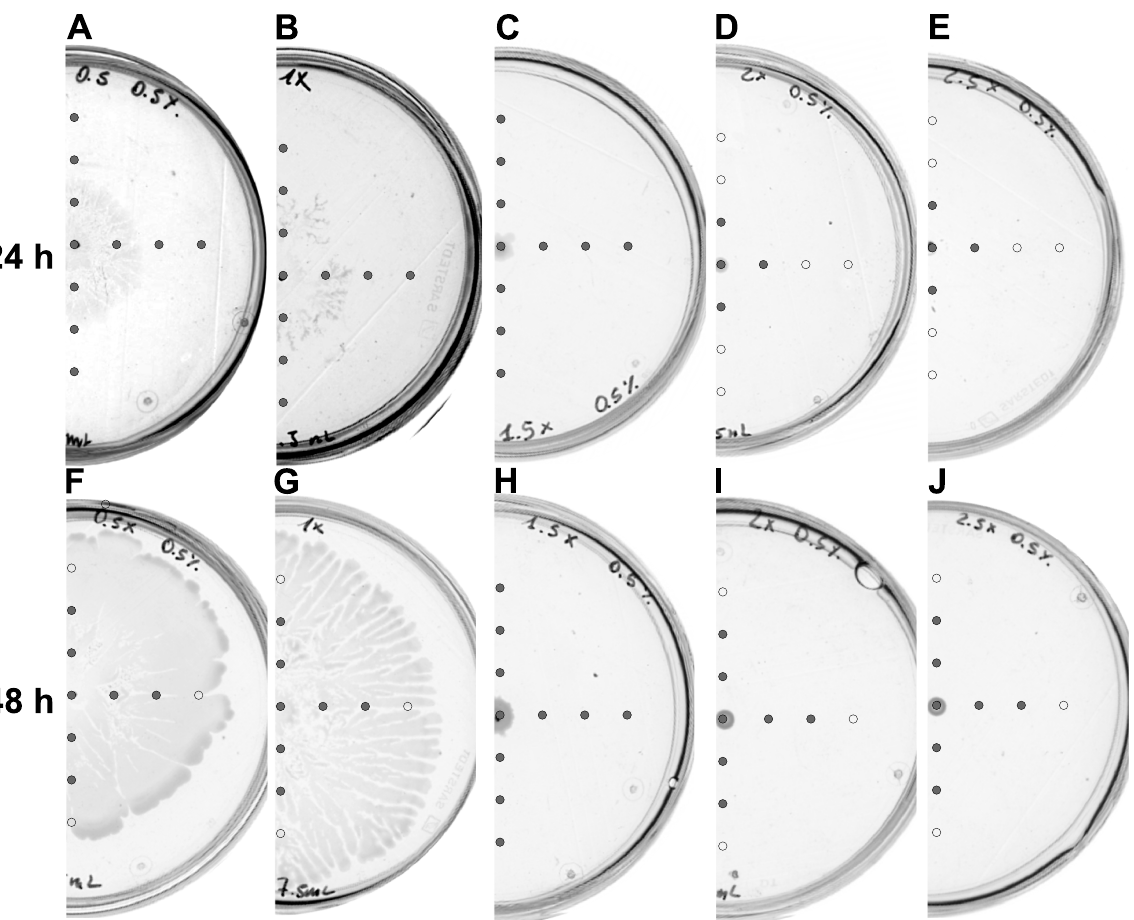
Fig 3. Swarming and AHLs production by Dickeya solani IFB102 on plates containing 0.5% of glucose, 0.5% of agar and the following concentrations of remaining components of B-medium: (A, F) 0.5x, (B, G) 1x, (C, H) 1.5x, (D, I) 2x, (E, J) 2.5x. Swarming assays were performed for 24 and 48 h, as indicated. Grey circles represent spots at which AHLs were detected. Open circles represent spots at which no AHLs were detected.